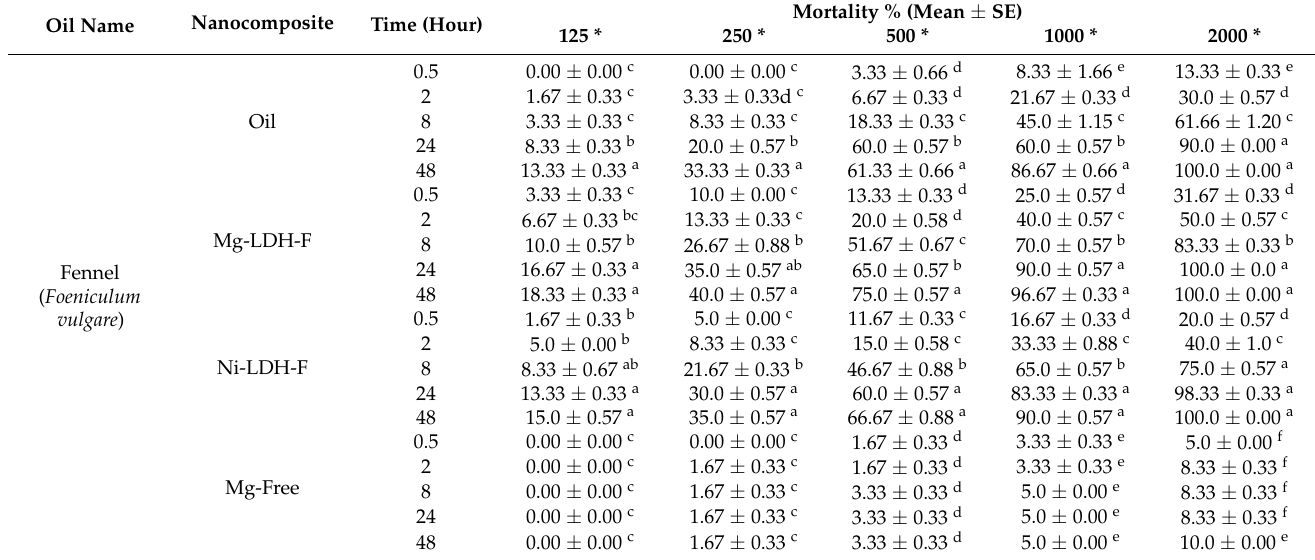
Table 2. Larvicidal effects of fennel oil and its LDH against Culex pipiens , 48 h post treatments.